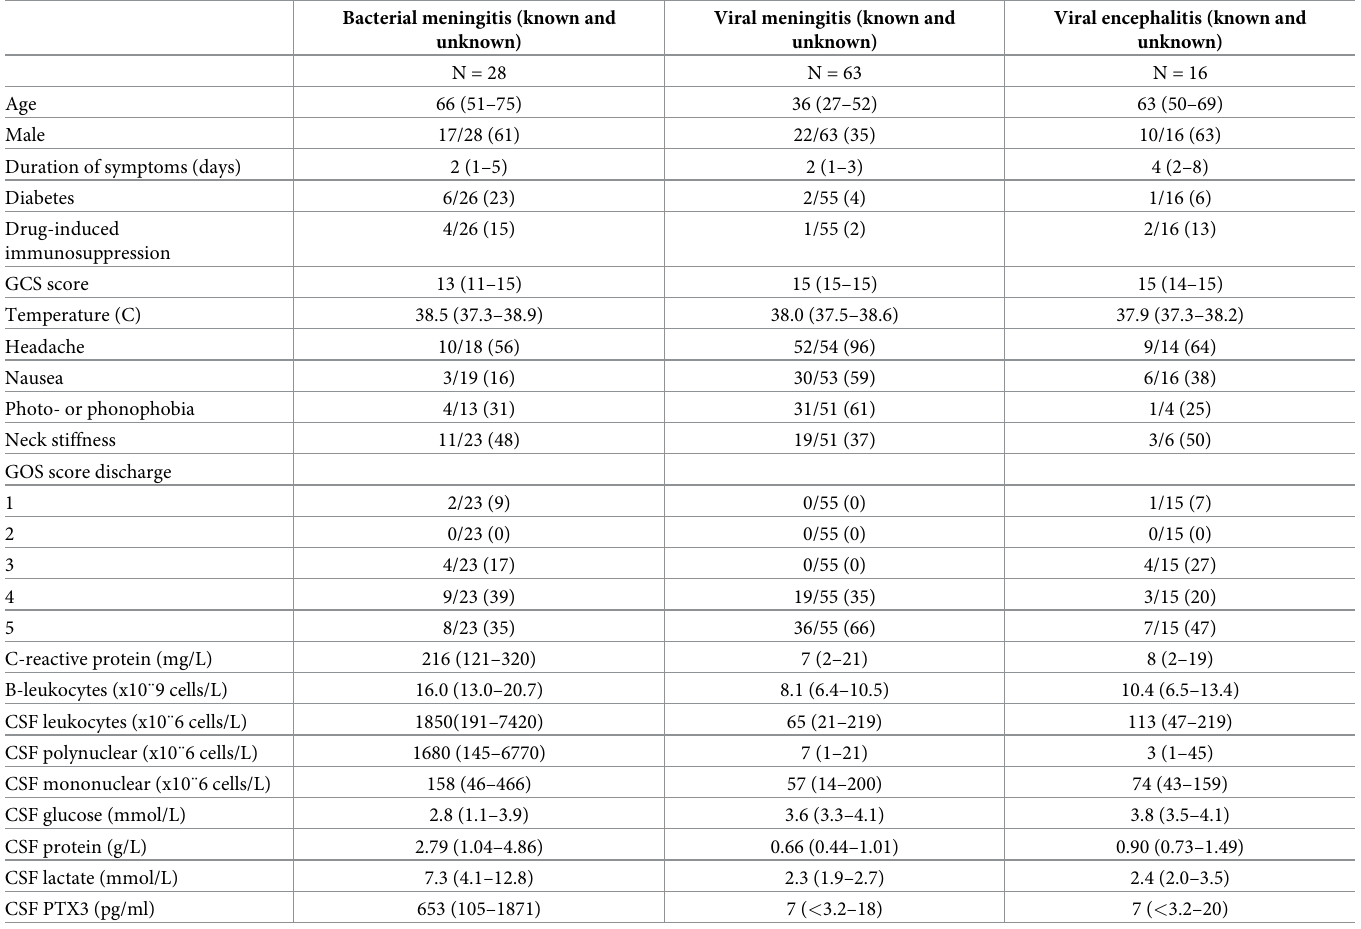
Table 2. Baseline characteristics of CNS infections with known and unknown